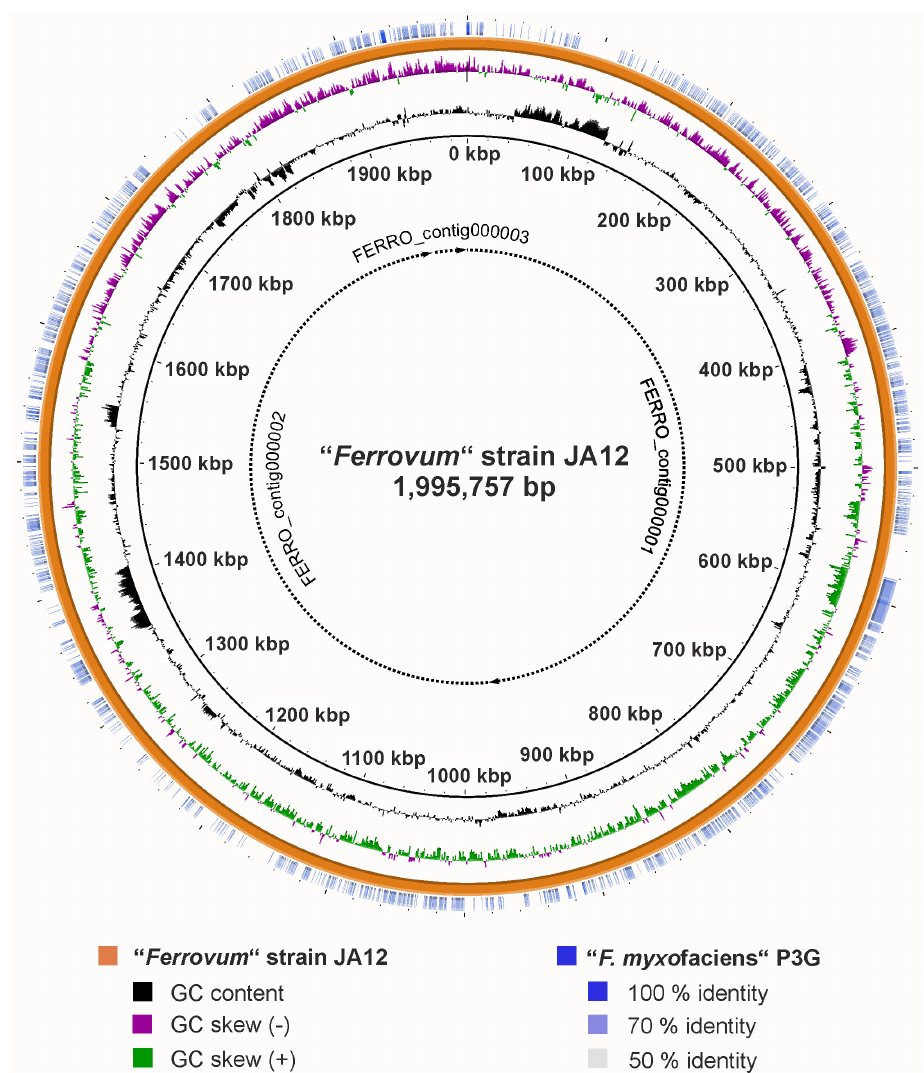
Fig 1. Artificial circular plot of the “ Ferrovum ” strain JA12 genome. The three contigs of “ Ferrovum ” strain JA12 were concatenated to form an artificial circular genome in the order FERRO_contig000001, FERRO_contig000002 and FERRO_contig000003 (broken lines). The origin of replication is not indicated. G +C content and GC skew of the genome of “ Ferrovum ” strain JA12 are shown on ring 1 and 2 from the inside, respectively. The Blastn-based whole genome comparison of “ Ferrovum ” strain JA12 and “ F . myxofaciens ” P3G was conducted using BRIG [47] with the genome sequence of “ Ferrovum ” strain JA12 set as reference (ring 3, orange). Blastn matches of “ F . myxofaciens ” P3G to the reference are shown on ring 4 (blue) with the colour intensity indicating the sequence identity of the match.